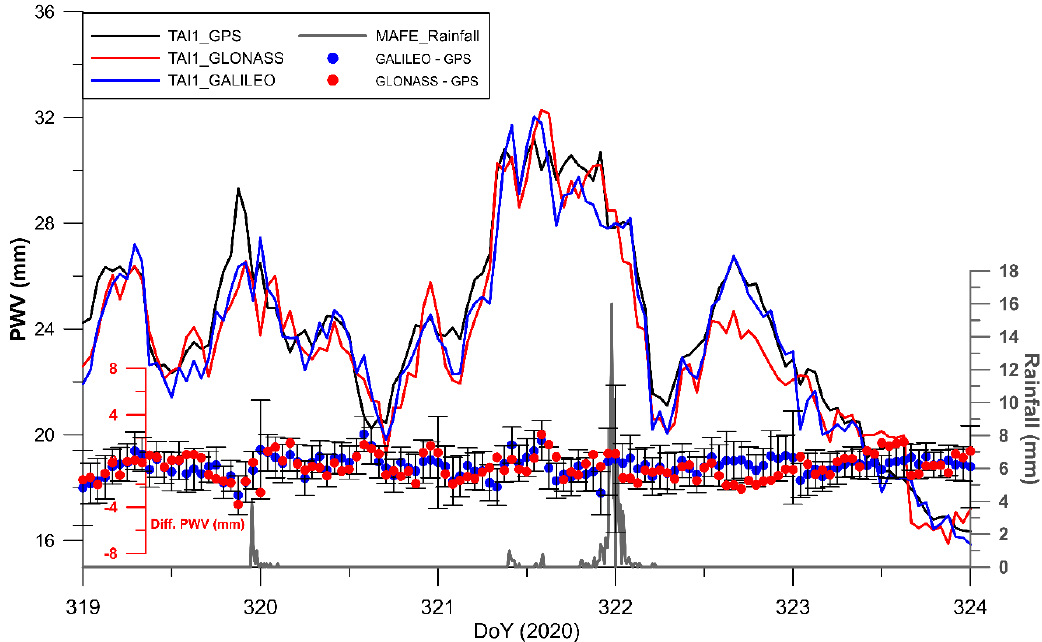
Figure 11. Hourly PWV values retrieved from Gamit analysis at the GNSS station TAI1 for different satellite constellations. The inter-constellation difference and rainfall is also plotted.